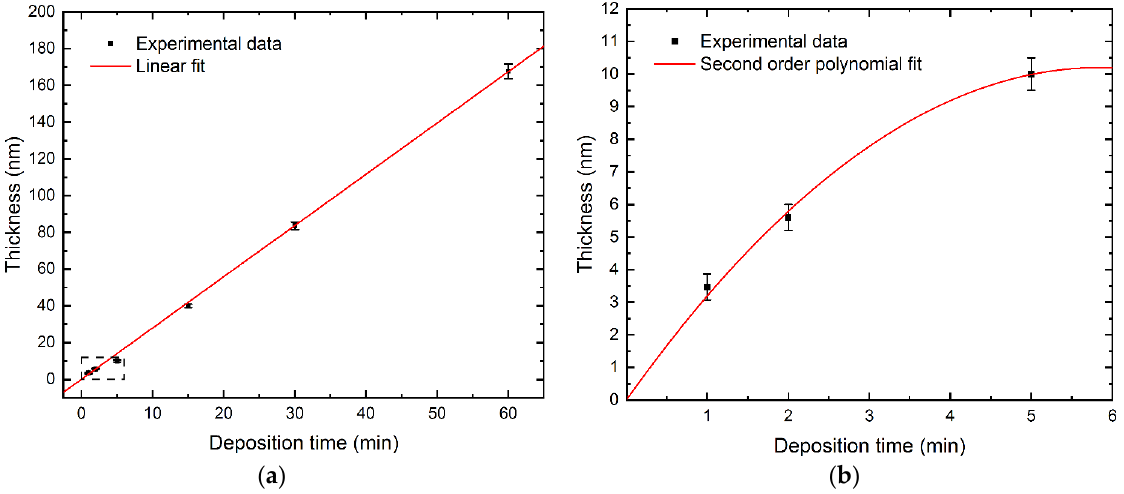
Figure 3. ( a ) Thickness evolution, with a linear fit, of the NCG films over the full range deposition time. ( b ) Enhancement of the dotted squared area in ( a ), representing the thickness evolution over the first 5 min of growth, with a second order polynomial fit.